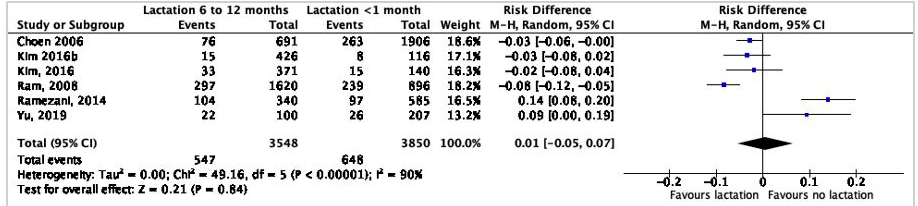
Figure 2. Adjusted odds ration with 95% confidence intervals across studies.